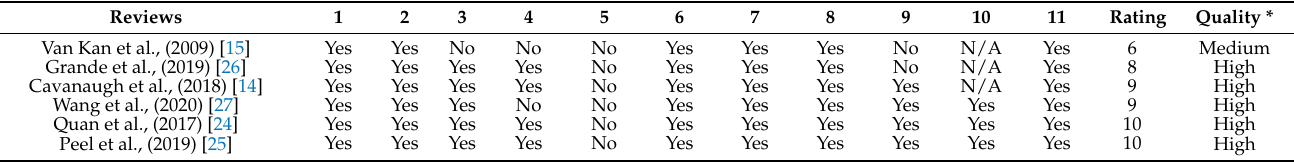
Table 2. Quality assessment of the systematic reviews included using the AMSTAR # rating